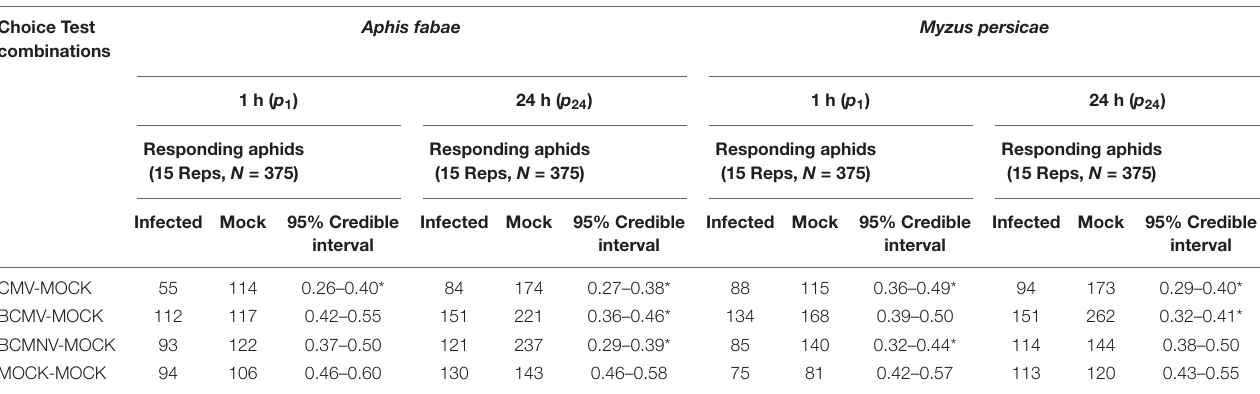
TABLE 1 | Analysis of aphid settling choices in different choice test combinations under normal illumination. Choice Test